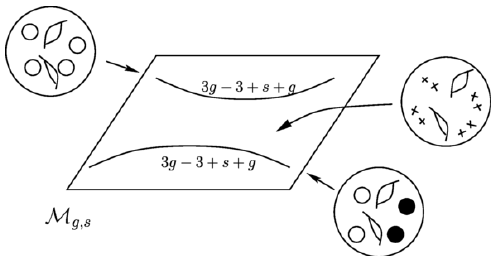
Figure 8 . Conformal manifold of a general theory of G max = so (5) u (1). At general point the notion of type of puncture is non existent since the relevant symmetries are broken. On sub-loci symmetries are enhanced and the punctures can be distinguished by their